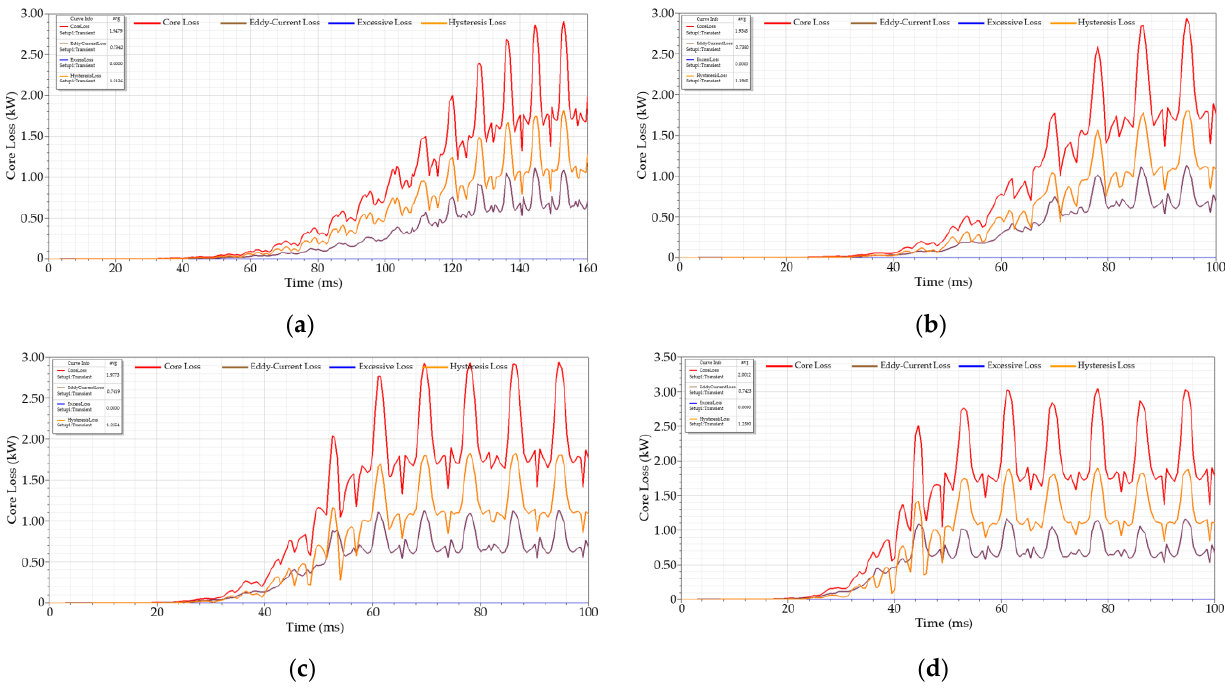
Figure 13. Simulation results of the core loss under the proposed equation. ( a ) 𝛾 = 25 ; ( b ) 𝛾 = 50 ; ( c ) 𝛾 = 75 ; ( d ) 𝛾 = 100. Table 5. Simulation results of the core loss under different slow start functions.